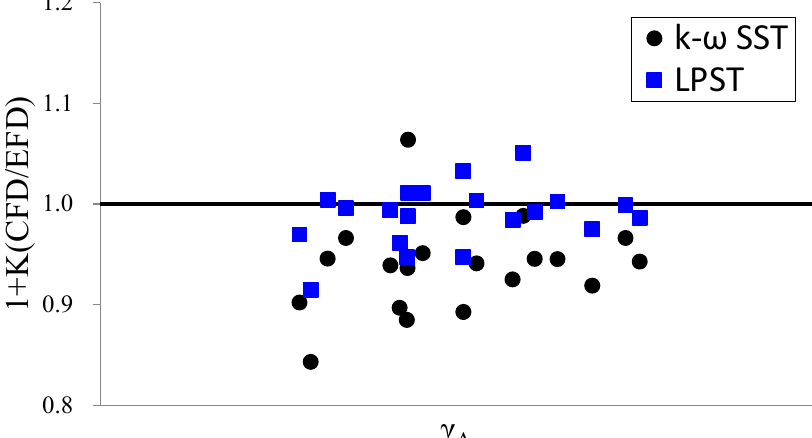
Figure 13. Result of CFD calculation (1 + K ).